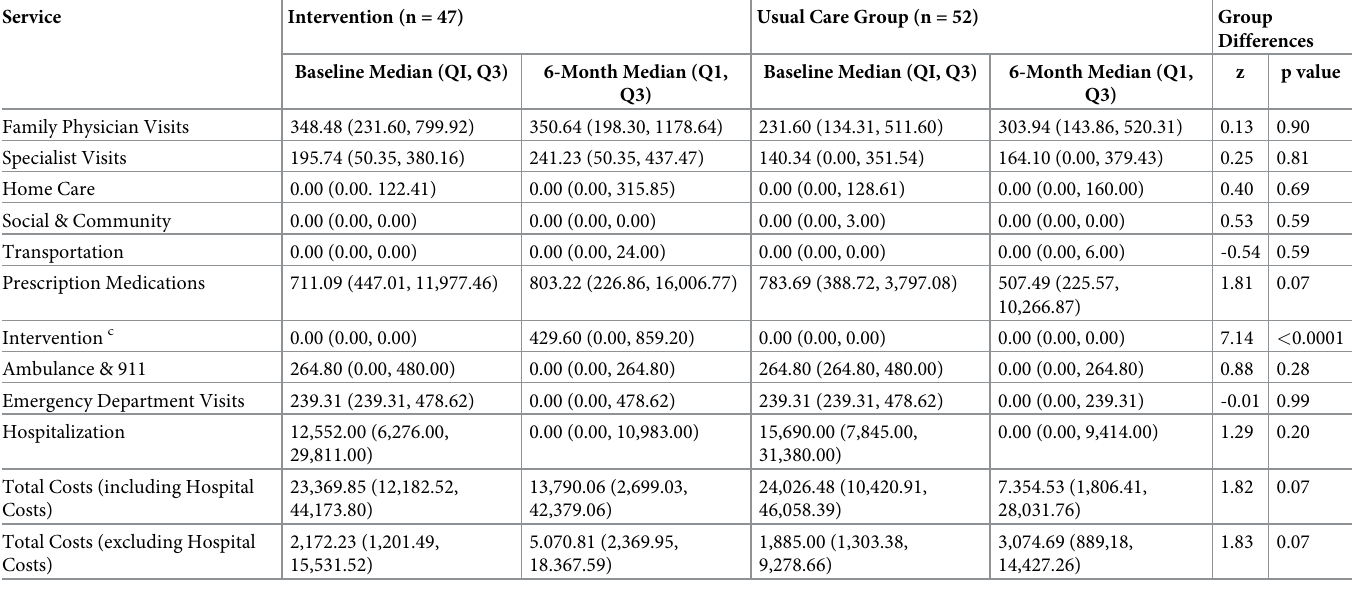
Table 4. Group difference in health and service costs a from baseline to six-months (n =